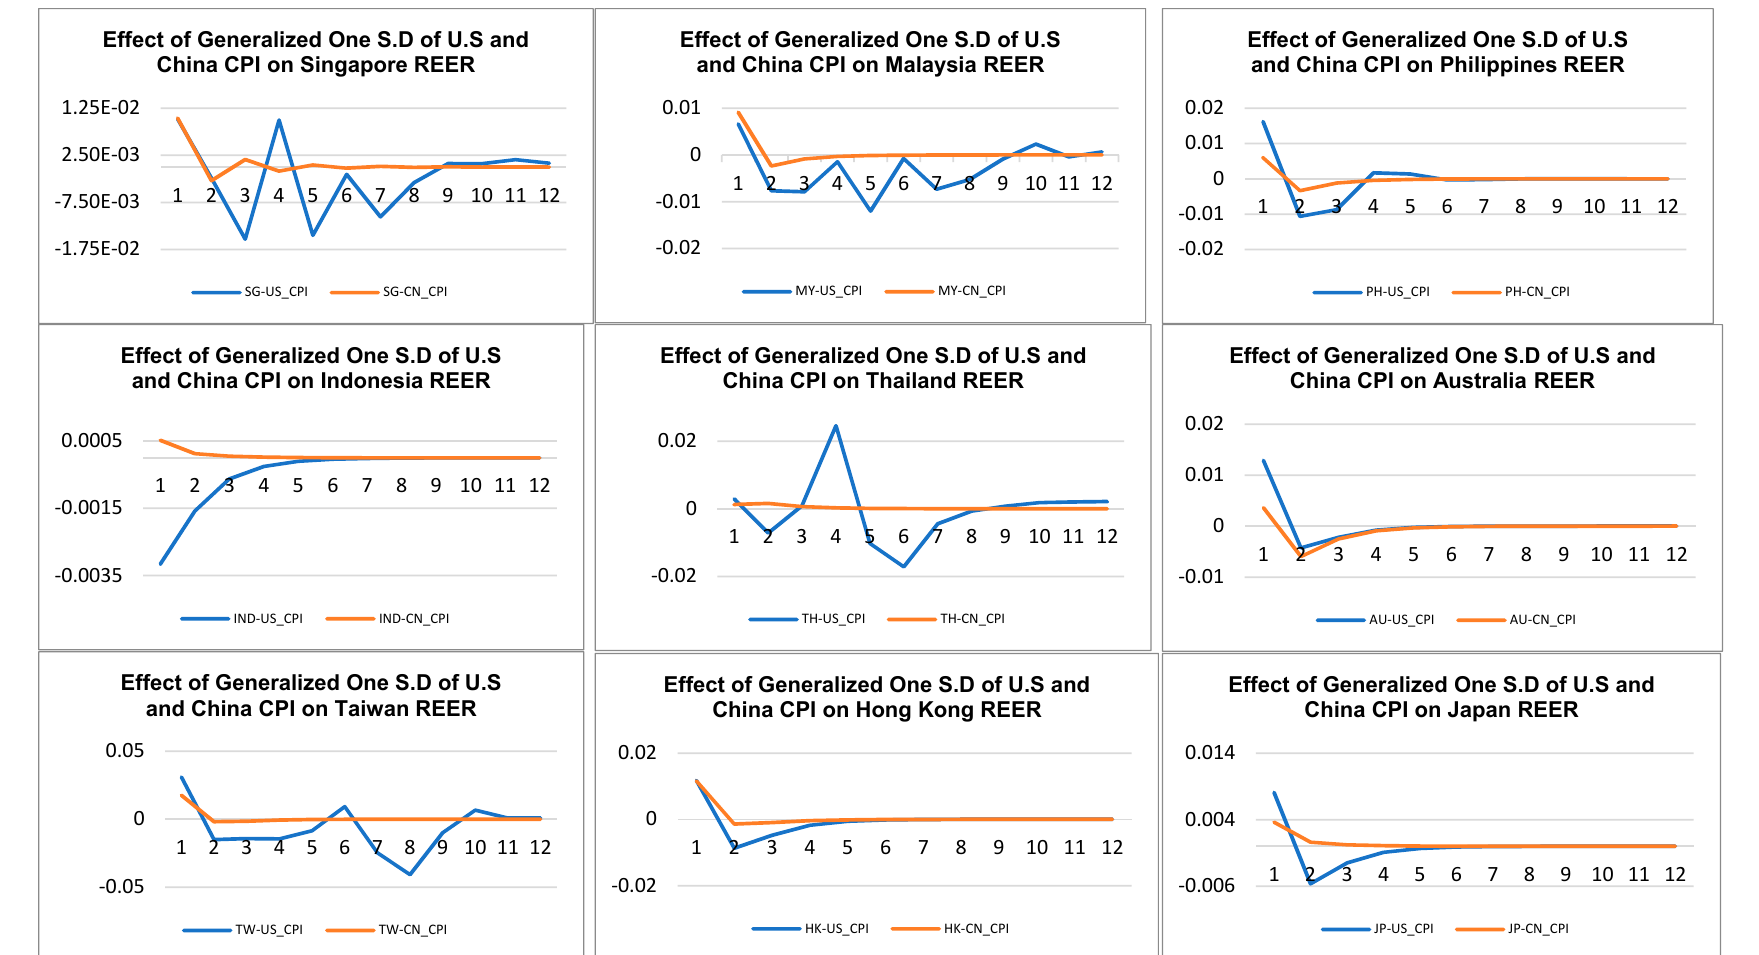
Figure 4. VAR estimations of the impact of innovations of one standard deviation in the US and China consumer price index (CPI) on the APAC REERs .